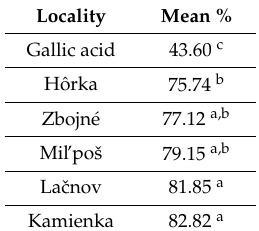
Table 4. Multiple range analysis for antioxidant activity of CB extracts by